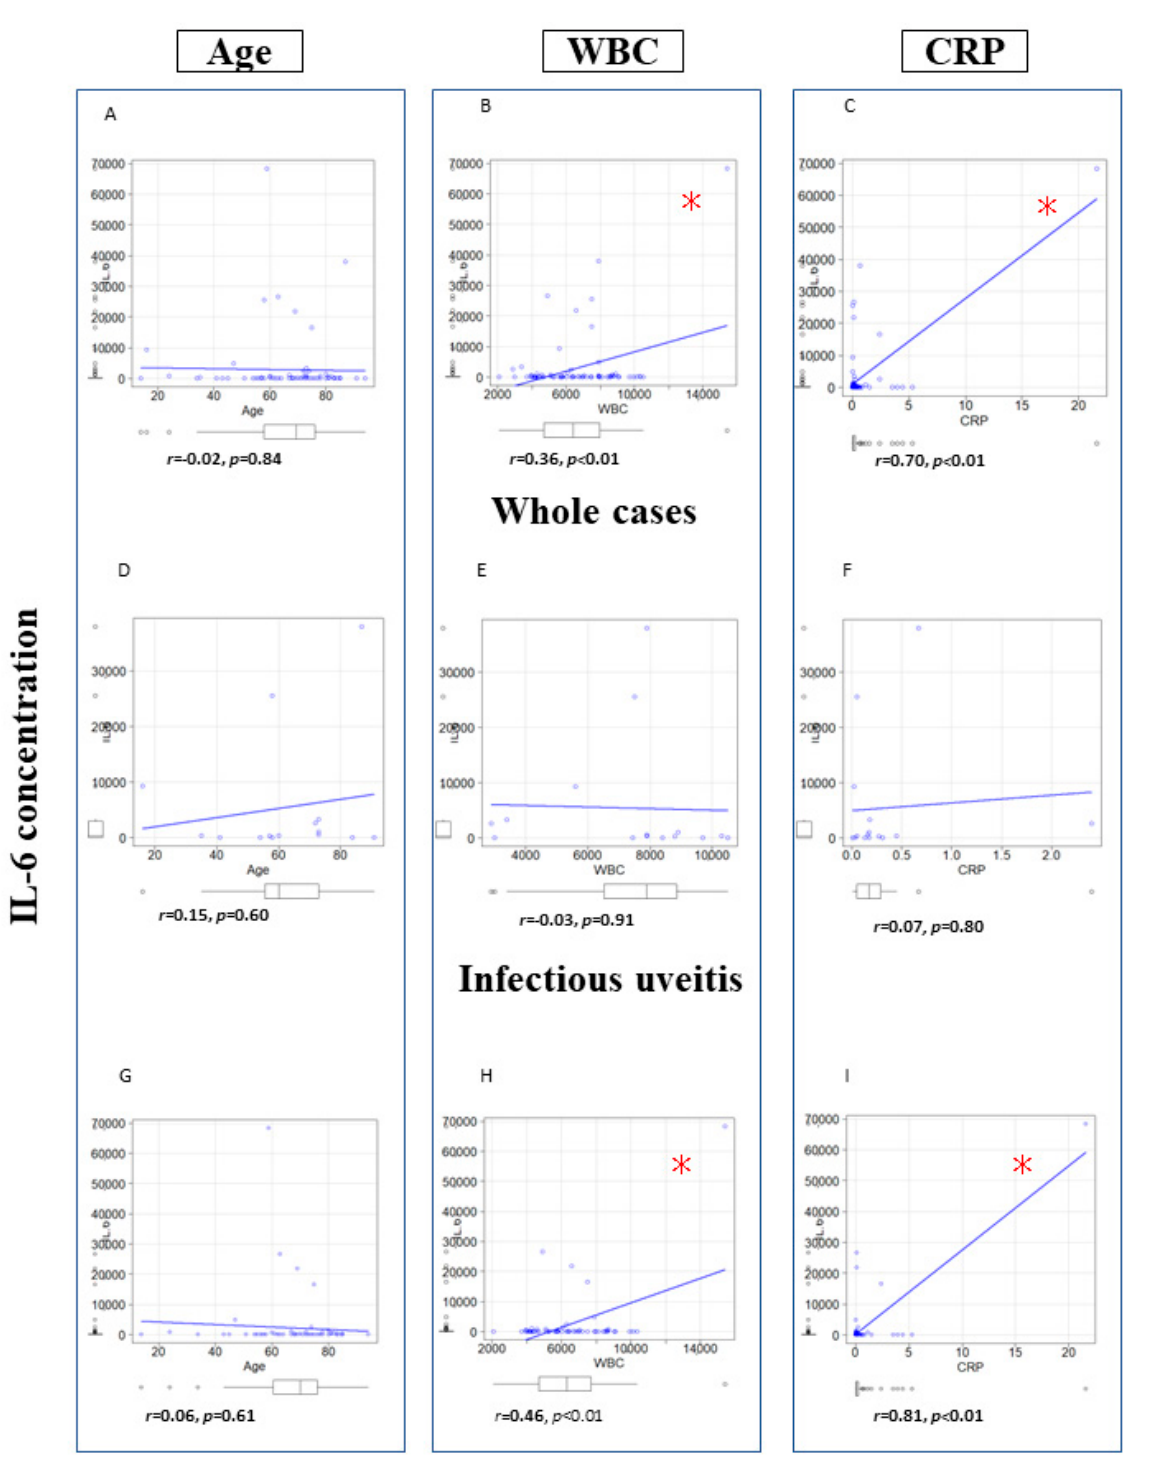
Figure 1. Scatter plots depicting vitreous IL-6 concentration correlations with age, WBC and CRP. ( A ): Correlation of IL-6 and age in whole cases. ( B ): Correlation of IL-6 and WBC in whole cases. ( C ): Correlation of IL-6 and CRP in whole cases. ( D ): Correlation of IL-6 and age in infectious uveitis. ( E ): Correlation of IL-6 and WBC in infectious uveitis. ( F ): Correlation of IL-6 and CRP in infectious uveitis. ( G ): Correlation of IL-6 and age in non-infectious uveitis. ( H ): Correlation of IL-6 and WBC in non-infectious uveitis. ( I ): Correlation of IL-6 and CRP in non-infectious uveitis. * p < 0.01. Pearson correlation coefficient. WBC: White blood cell, CRP: C-reactive protein, IL-6: